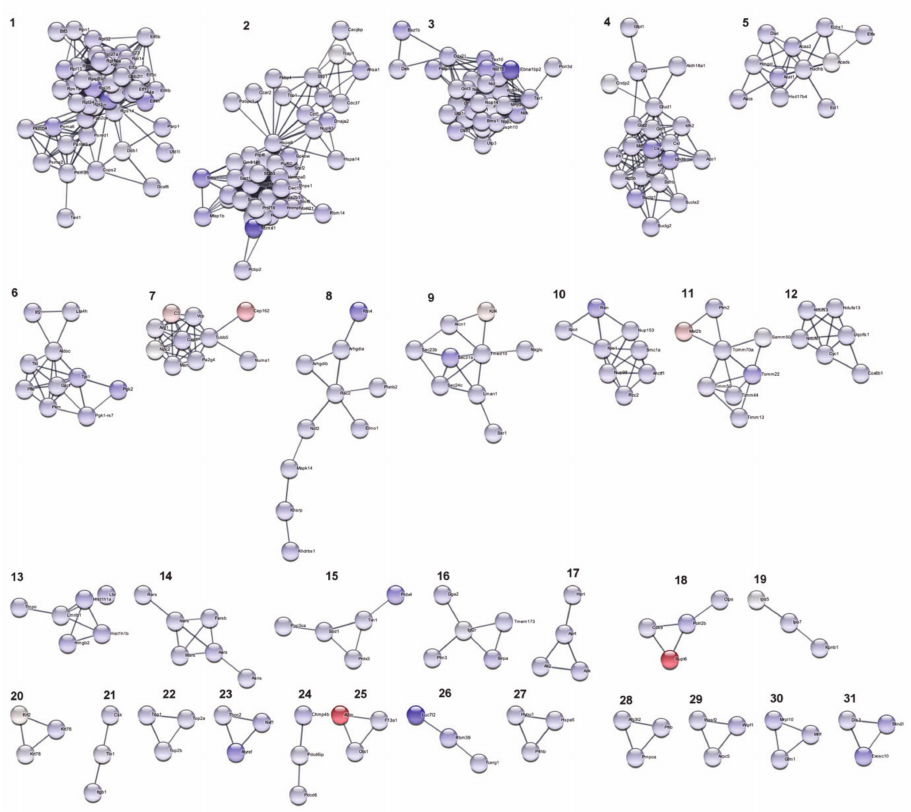
Figure 2. STRING network of PMJ2-R proteins with significant regulation levels. Expression ratios were mapped to the nodes using blue-red gradient, where blue is related to the downregulated and red to the upregulated proteins. Proteins without interaction partners were omitted from the visualization. Network edges represent the confidence of interaction. The required interaction score was set to